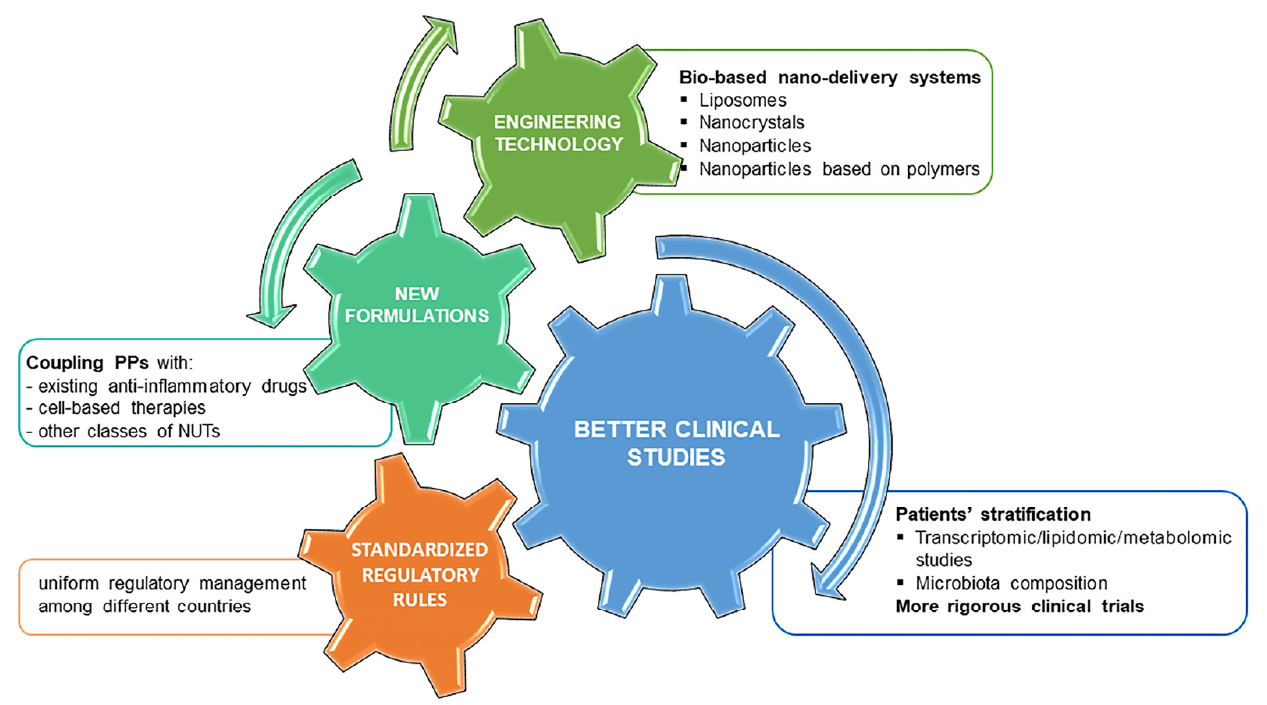
Figure 4. Overview of main perspectives to improve future research approaches studying PPs.